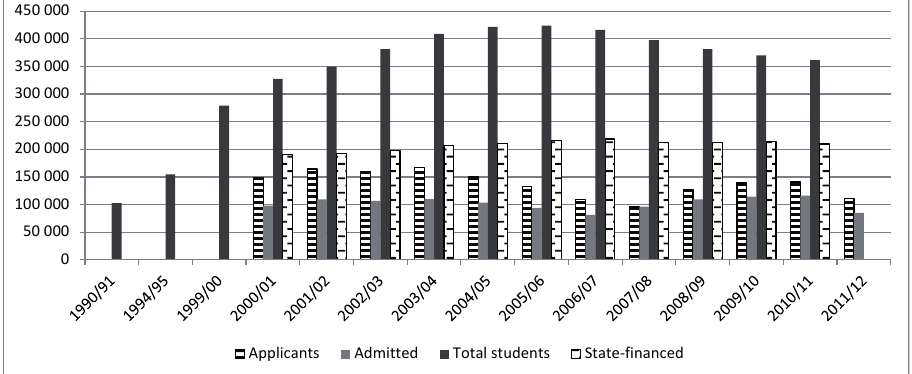
Figure 1. The applicants, admitted, state-  nanced and total number of students of the Hungarian higher education system,